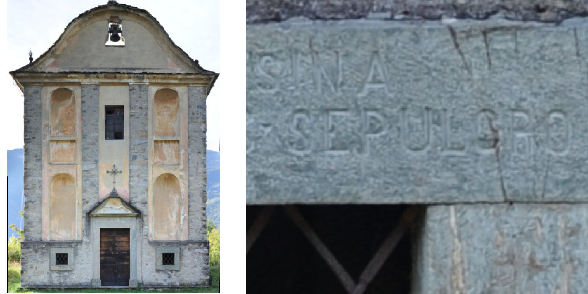
Fig. 5. A rectified projection (6512×8900 pix) and a particular showing the level of detail obtained (1 pix = 1×1 mm 2 ).